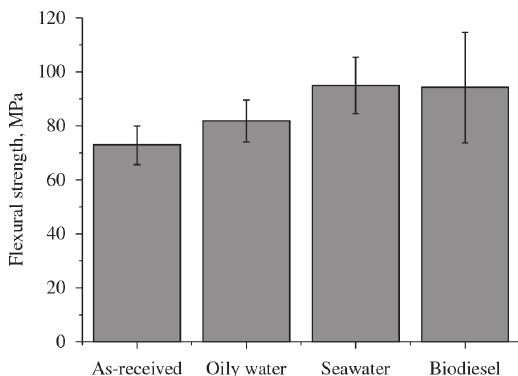
Figure 5. Variation of the flexural strength of the aged composites in respect to the as-received material.